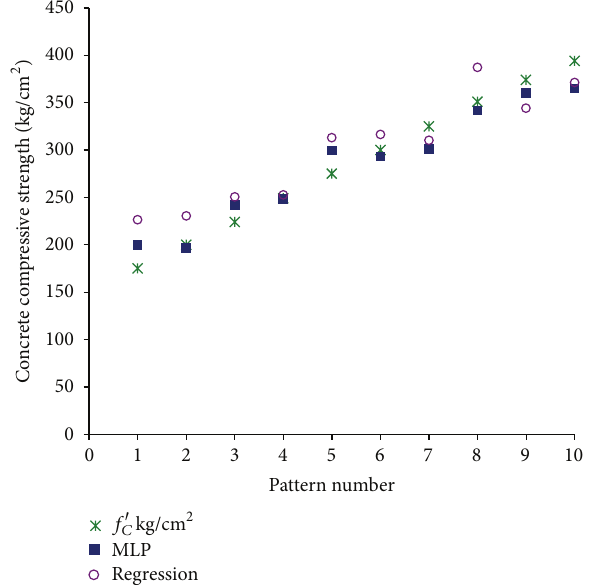
Figure 7: Prediction of compressive strength of concrete with EANN (MLP) and MLR regression